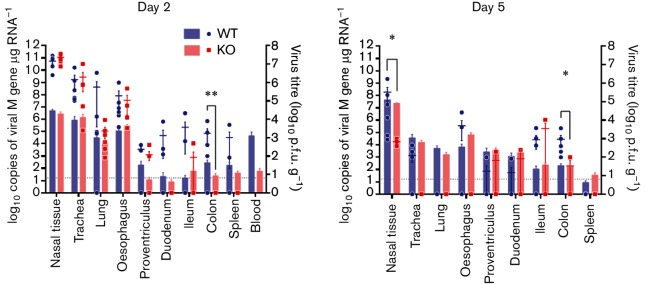
Viral titres in tissues harvested from high-dose-inoculated chickens. A panel of respiratory and gastrointestinal chicken tissues were harvested from the chickens inoculated with 1×105 (high dose) of either WT (blue) or KO (red) UDL01 influenza virus. Tissues were harvested and processed at (a) 2 or (b) 5 days post inoculation. Copies of viral M gene vRNA (left axis) were determined via influenza specific qPCR on total tissue RNA (bars). Infectious virus (right axis) was determined by virus titration of homogenized chicken tissues (circles/squares). Grey dotted base lines indicate the limit of infectious virus detection. Means±sem were calculated from a minimum of three individual animals. Levels of significance were based upon P-values from Student t-tests; * P<0.05 for infectious virus, ∗∗P<0.05 for copies of viral mRNA.